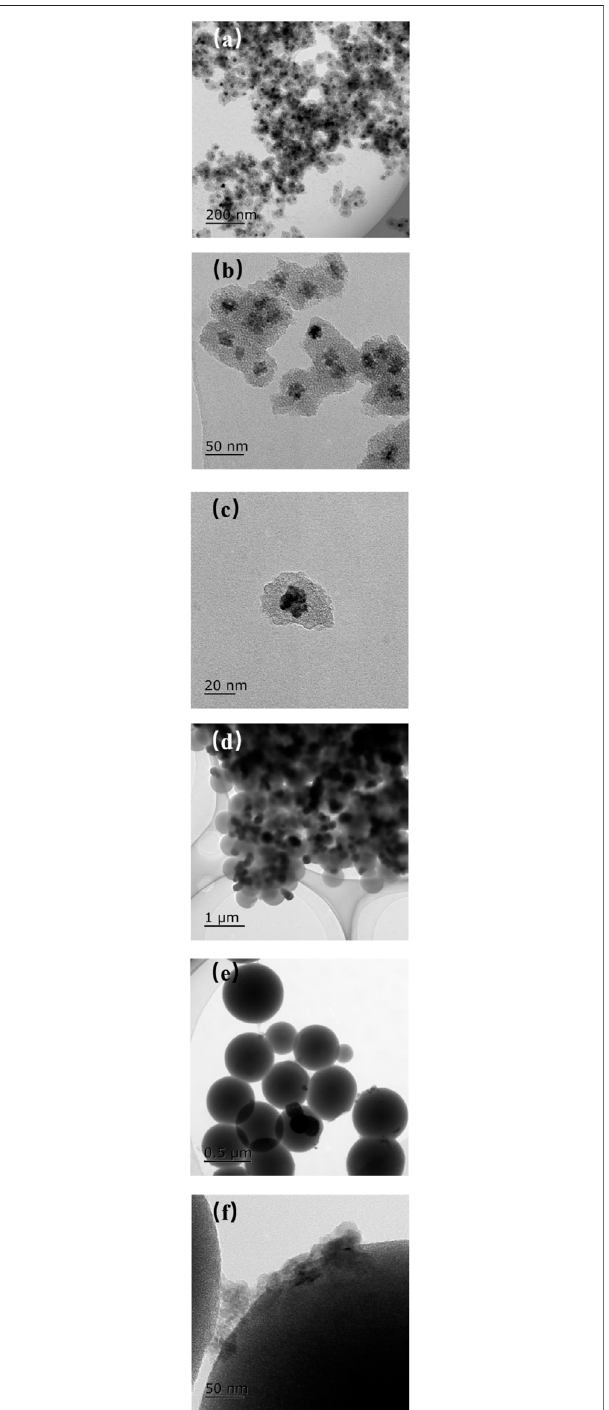
FIGURE 1 | Scanning electron microscope images of Co 3 O 4 @SiO 2 (A – C) and 25Co 3 O 4 /SiO 2 (D – F) .